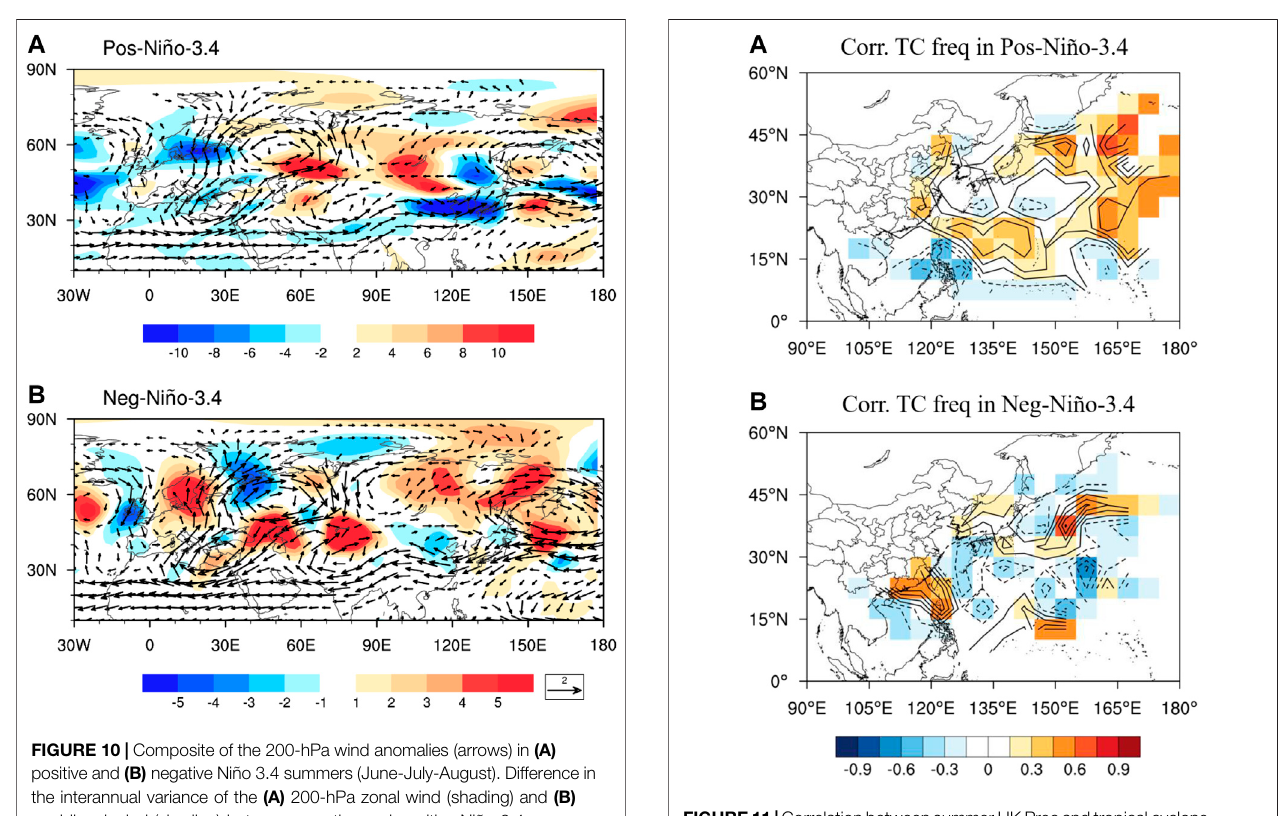
FIGURE11| CorrelationbetweensummerHKPrecandtropicalcyclone track density in (A) positive Niño-3.4 summers and (B) negative Niño-3.4 summers. Tropical cyclone tracks were obtained from the Joint Typhoon Warning Center (https://www.metoc.navy.mil/jtwc/jtwc.html?western- paci fi